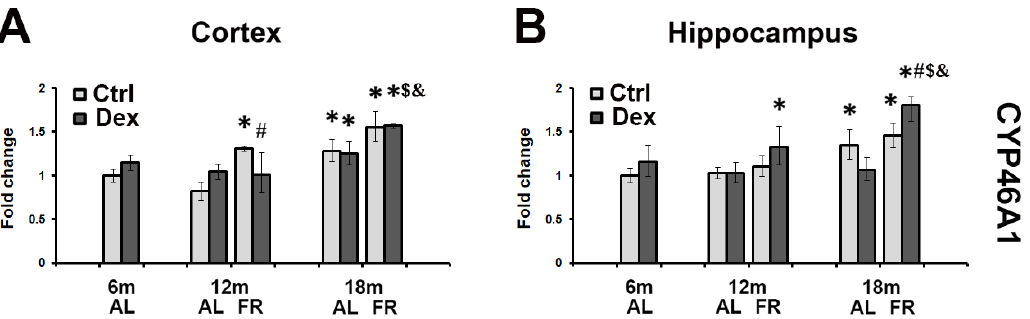
Figure 4. The effects of dexamethasone on CYP46A1 mRNA level in the cortex ( A ) and hippocampus ( B ) of rats fed ad libitum (AL; light gray bars) and following long-term food restriction (FR; dark gray bars) during aging. Dexamethasone was applied in a dose of 4 mg/kg (single i.p. injection). Values were obtained by semiquantitative qRT-PCR. Histogram represents mRNA levels expressed as ratio (fold change) calculated relative to the values obtained in 6-month-old rats. In order to obtain the differences between the experimental groups, nonparametric Mann–Whitney U Test was performed ( n = 5 rats per group). * p < 0.05 vs. 6-month-old rats; # p < 0.05 vs. vehicle-treated rats, $ p < 0.05 vs. 6-month-old rats treated with Dex; & p < 0.05 vs. age-matched AL rats treated with